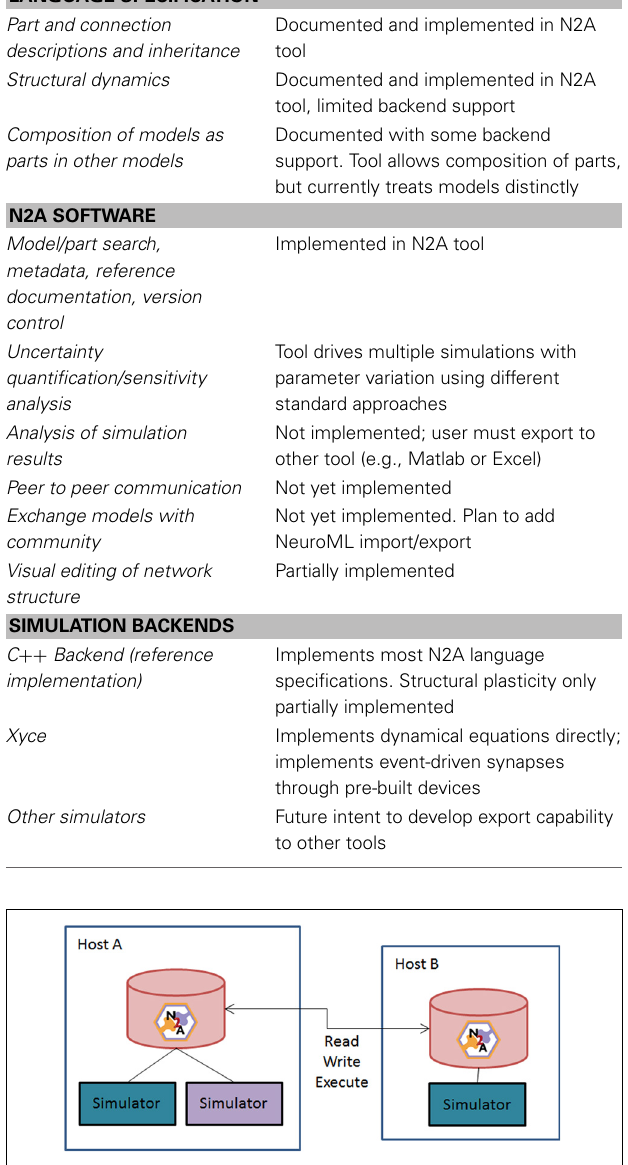
FIGURE 6 | Schematic of N2A peer-to-peer collaborative community vision. N2A can be run with either a local database or through a common network repository. Users will be able to directly share models between collaborators or with the broader community through opening their database to the broader neuroinformatics